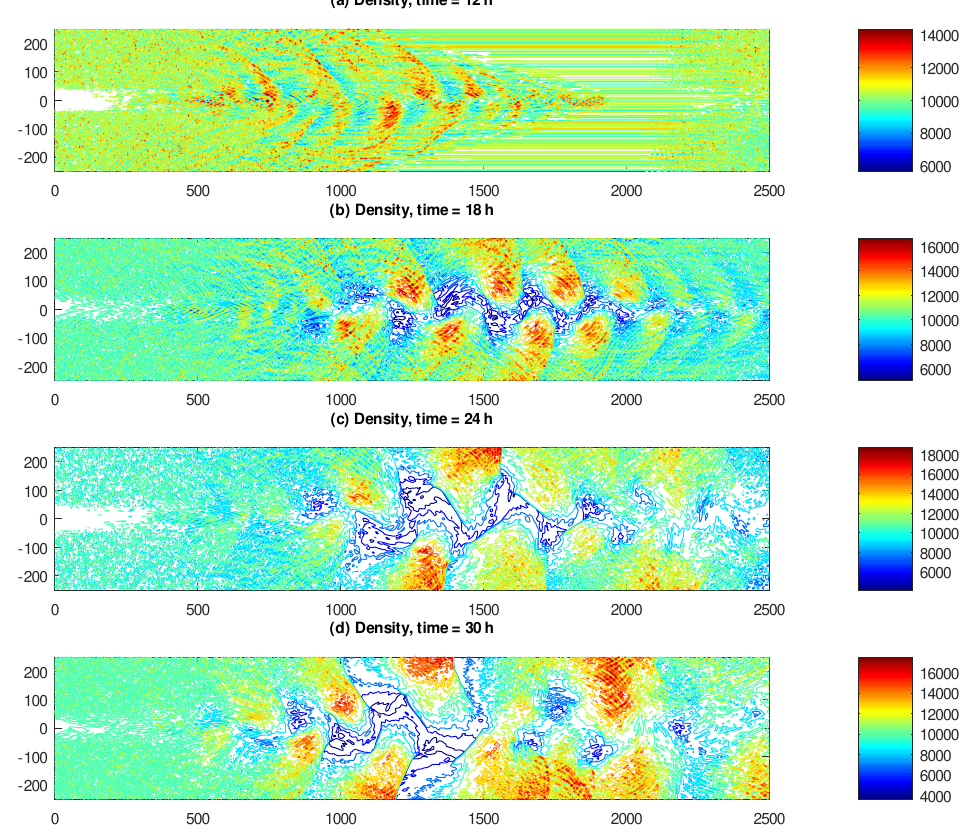
Figure 4. Density of the inertial flow, expressed in kg/m 2 , and captured at ( a ) 12, ( b ) 18, ( c ) 24 and ( d ) 30 h of elapsed model time. The domain size is 2500 × 500